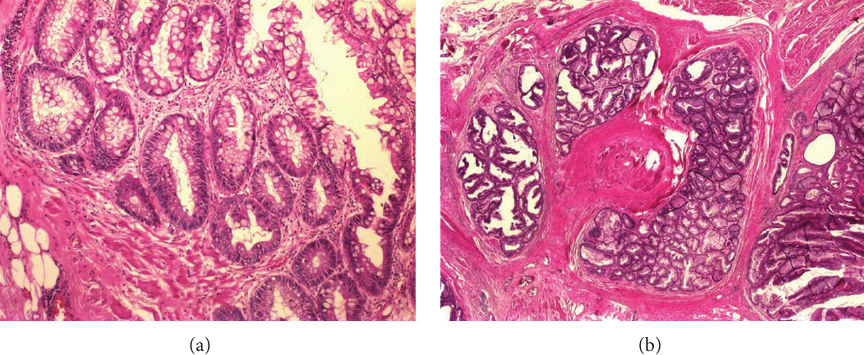
Figure 3: Microscopic examination revealed that the tumor has arised from a villous adenoma of the urachus. The pictures show that villous projections which were lined by columnar mucinous epithelium having pronounced nuclear and architectural atypia (a) and invasive area into the muscle wall